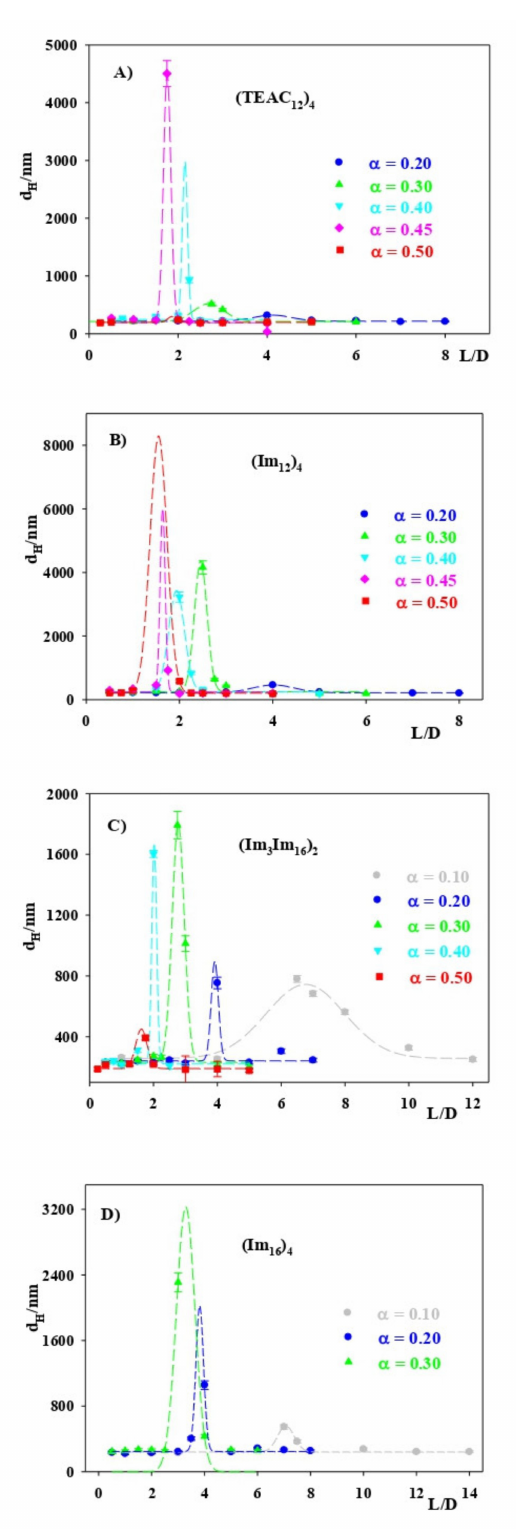
Figure 4. Dependence of the hydrodynamic diameter, d H , of the CAL/DOPE/DNA lipoplexes on L/D for different molar ratios α . T = 303 ± 0.1 K. ( A ) (TEAC 12 ) 4 ; ( B ) (Im 12 ) 4 ; ( C ) (Im 3 Im 16 ) 2 ; ( D ) (Im 16 ) 4